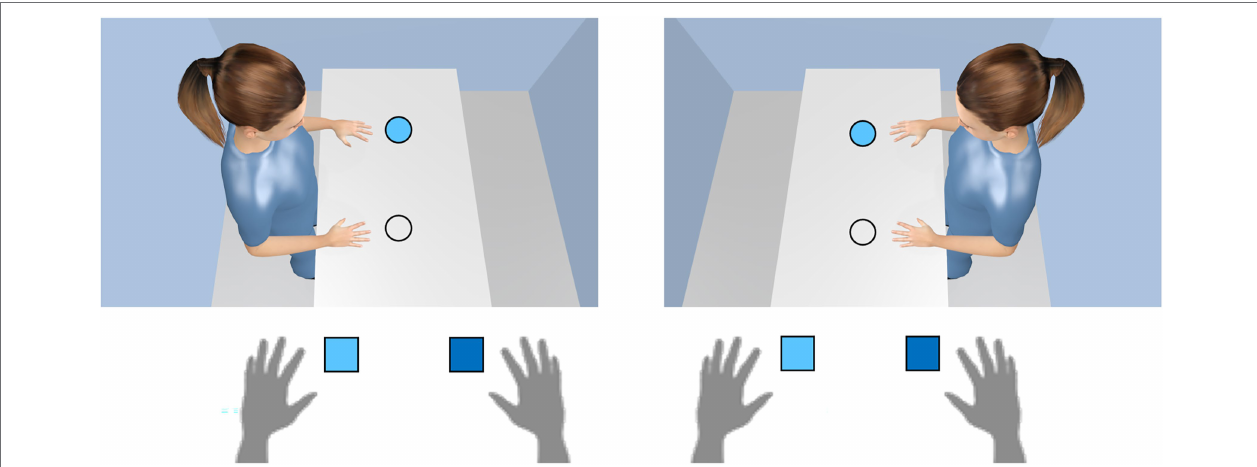
FIGURE 5 | The principle of the avatar-Simon task. Participant’s task is to press on a light (dark) blue disk a left (right) key (here with light blue disk only). Disk positions are randomly assigned to the upper and lower position (here the upper position only). In the left panel, a left response is required, which corresponds to the avatar’s left hand. In the right panel, a left response is also required, but it does not correspondent with the avatar’s left hand, but its right hand. As a result, reaction times and fewer errors are observed with the avatar on the left side than with the avatar on the right side.